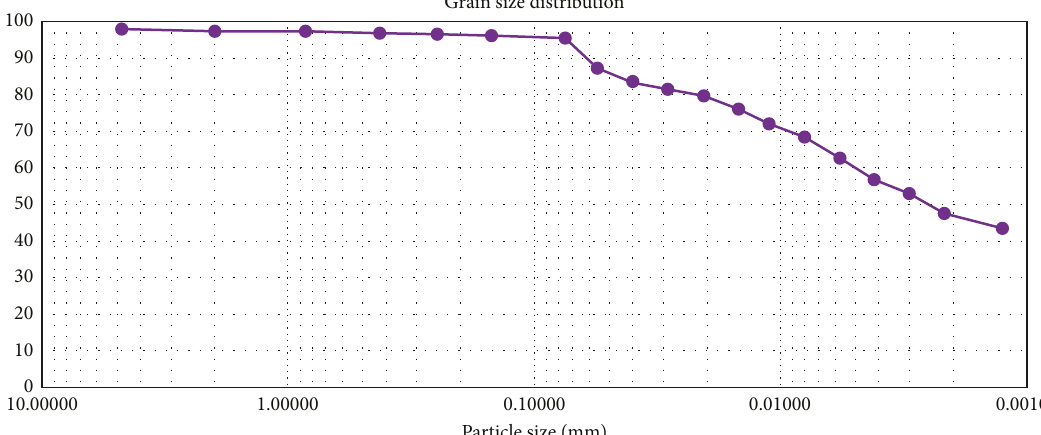
Figure 3: Grain size analysis